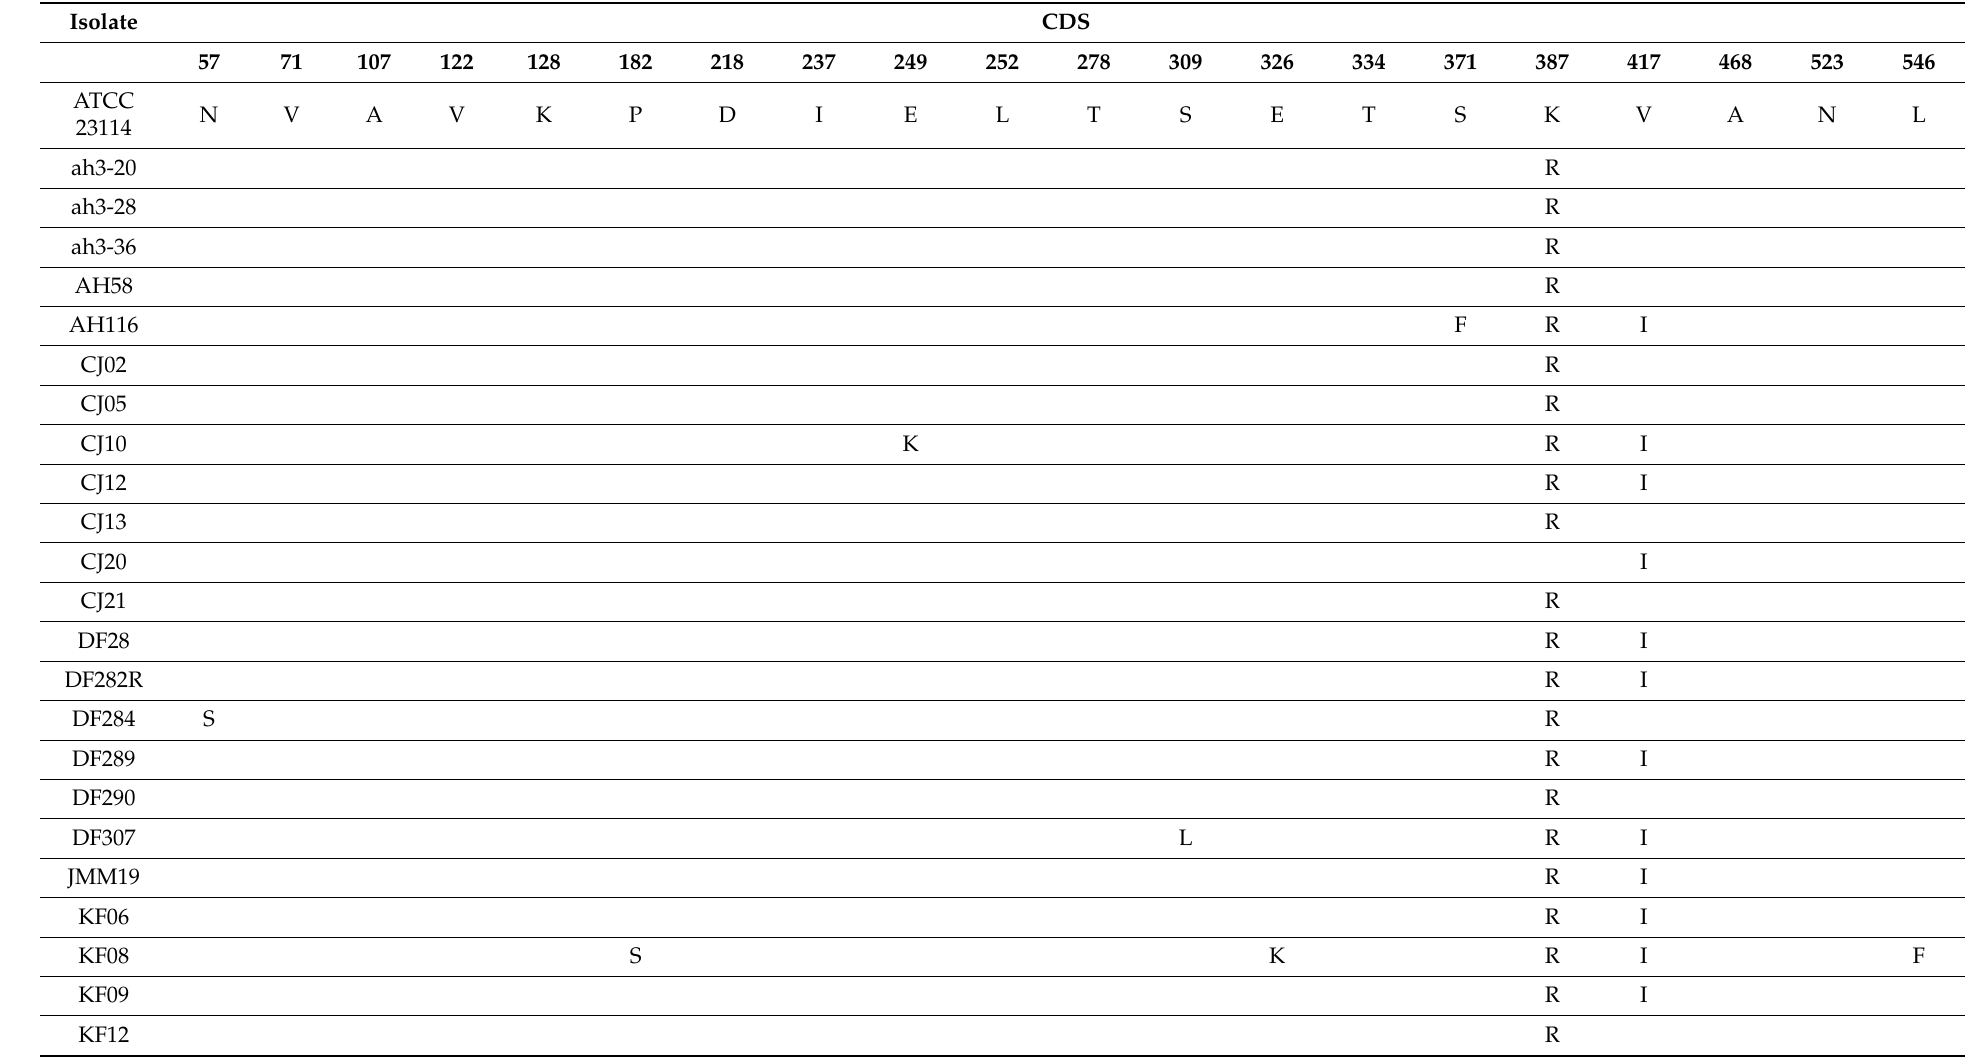
Table A6. Amino acid variations present in the parE genes of all isolates analyzed in reference to ATCC